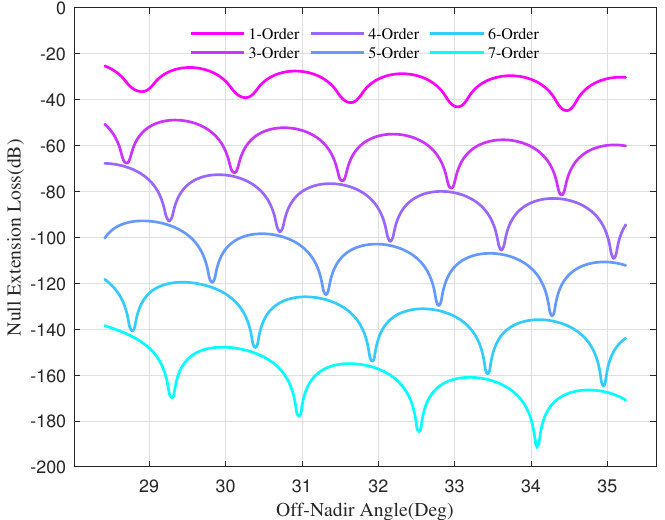
Figure 19. NEL effects corresponding to different null constraint orders for sub-swath